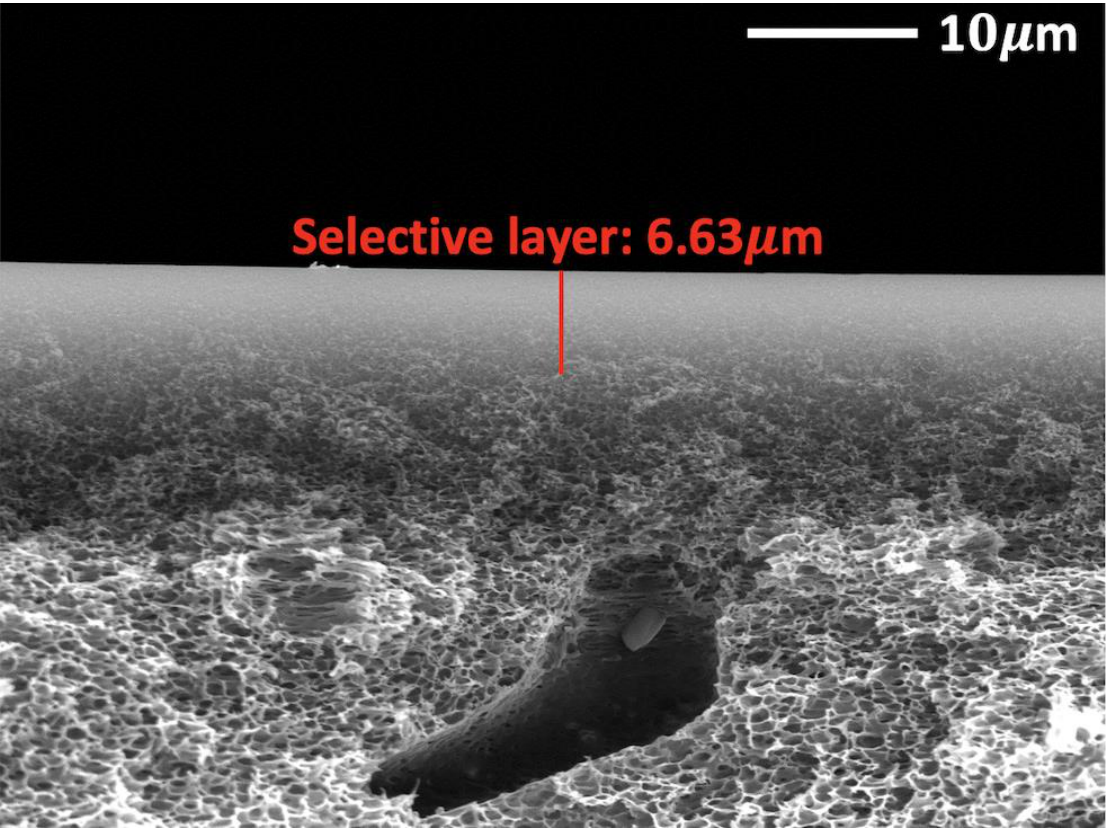
Figure 1. SEM image: PVP/CuO/TCNQ composite membrane coated onto polysulfone